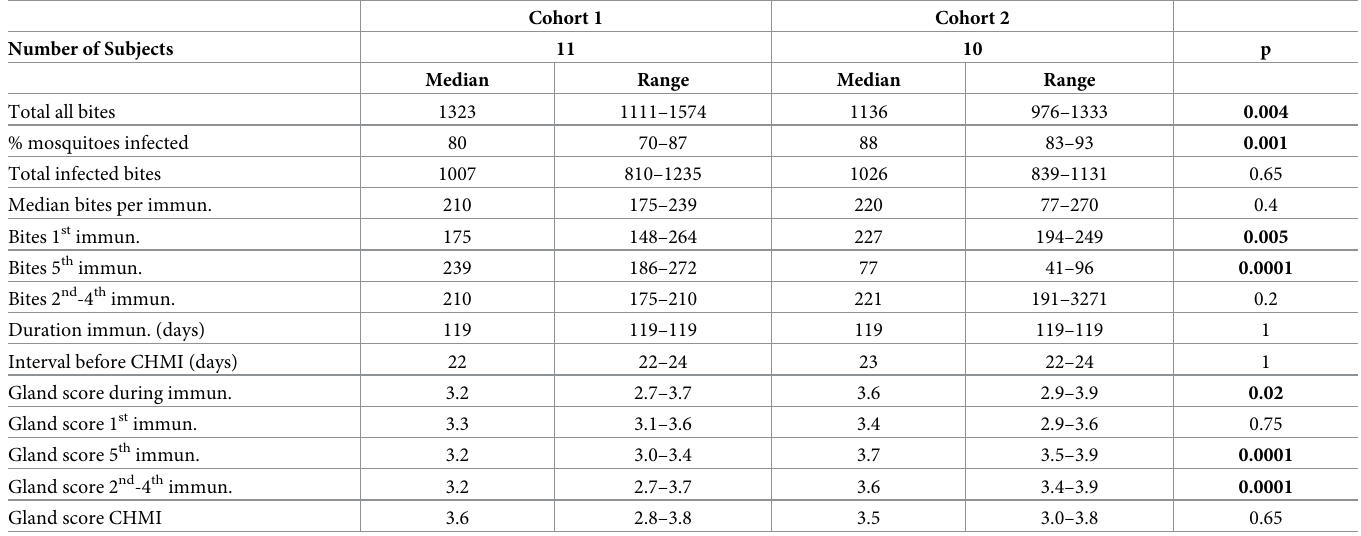
Table 6. Cohorts 1 and 2—Comparison of key parameters of